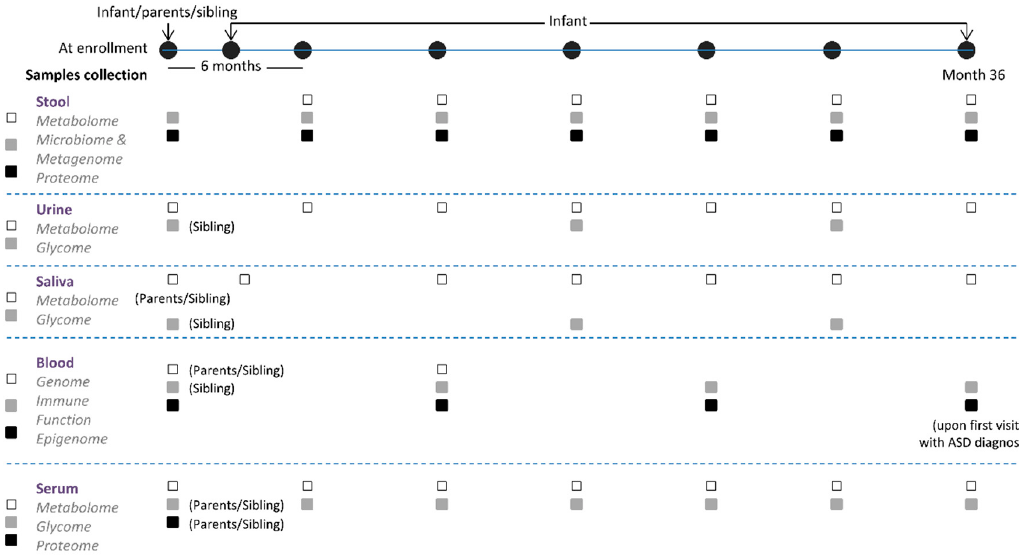
Figure 3. Clinical trials—prospective multi-center observational study evaluating infants at risk of ASD. 600 infants—newborns, less than 6 months of age—at risk, i.e., first-degree relatives of ASD individuals, recruited in US, Italy, and Ireland (200 infants at each site, over a 3-year period). Ongoing.